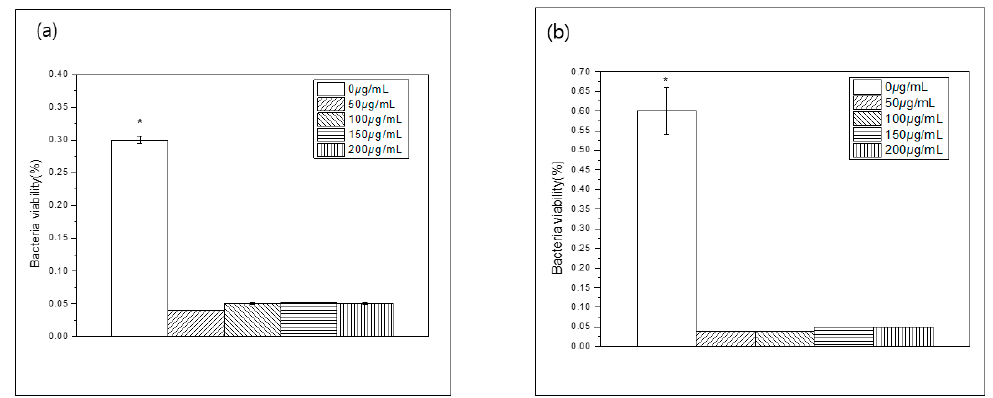
Figure 3. Result of bacteria viability test contents of 50 μ g/mL, 100 μ g/mL, 150 μ g/mL, and 200 μ g/mL ( a ) S. mutans group ( b ) C. albicans group. * The indicates statistics significant difference by One-Way ANOVA ( p < 0.05).